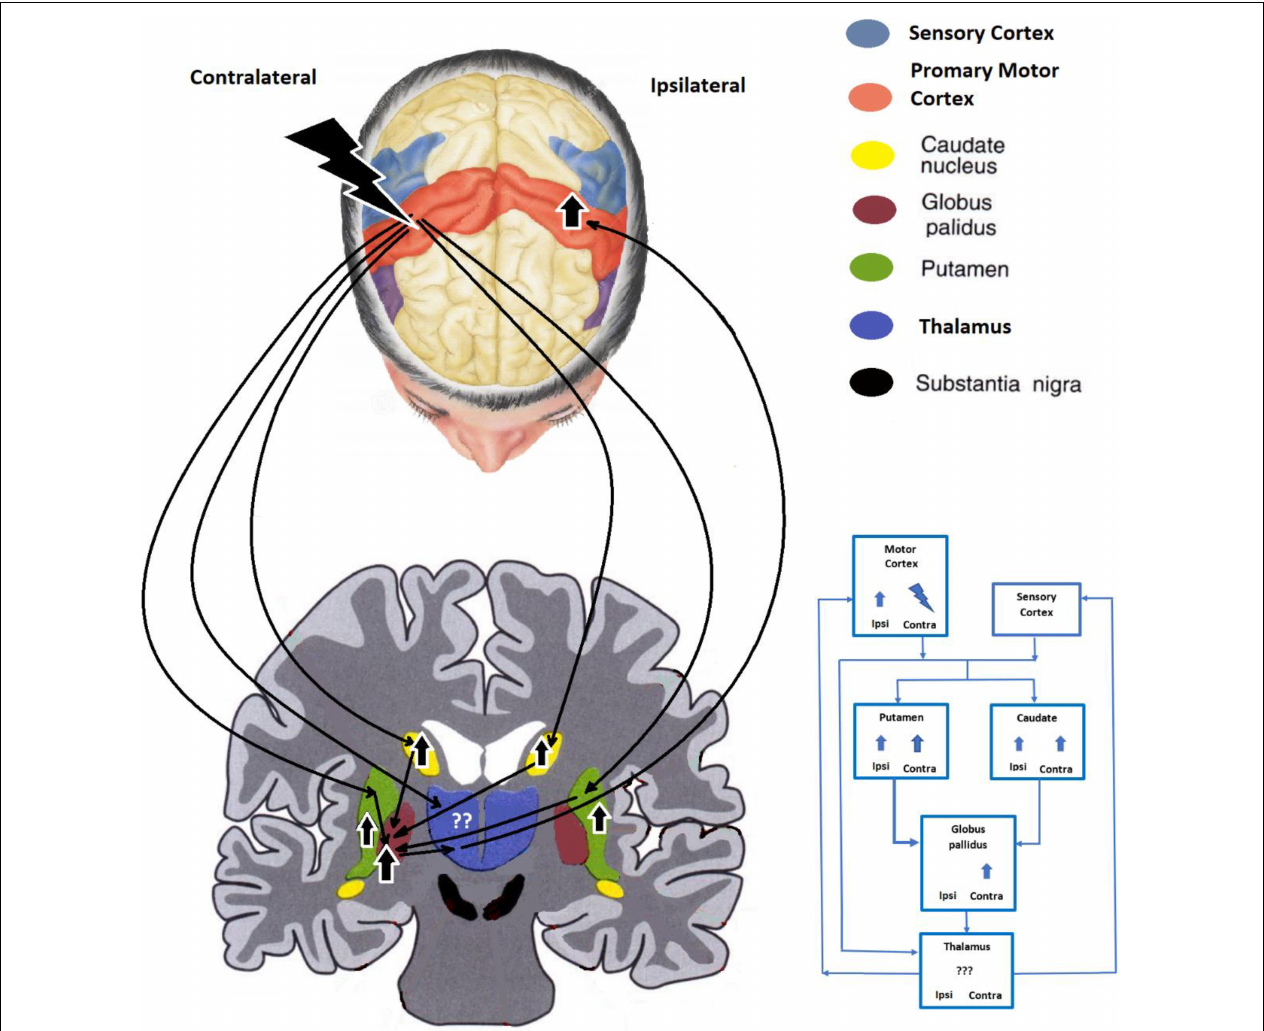
FIGURE 3 | The proposed anodic tDCS modulation pathway of the contralateral motor